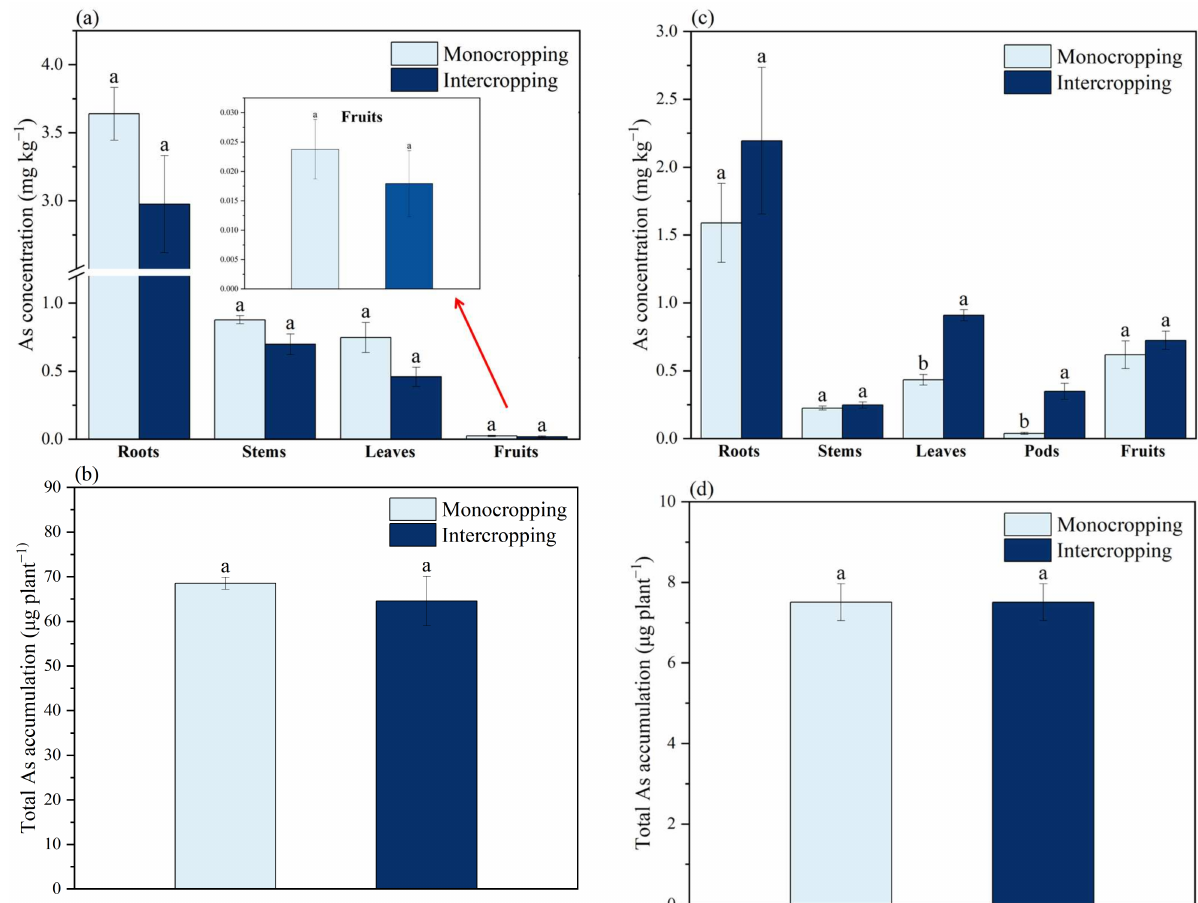
Figure 3. As concentrations and total Cd accumulation in L. cylindrica ( a , b ) and S. cassiae ( c , d ) under different planting systems. Different lowercase letters indicate significant ( p < 0.05) differences between the treatments according to Duncan’s